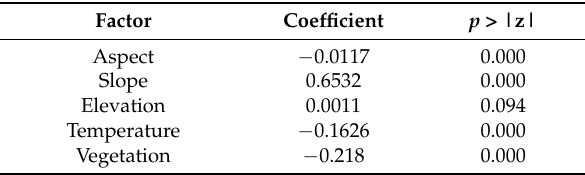
Table 2. Factor coefficients and their statistical